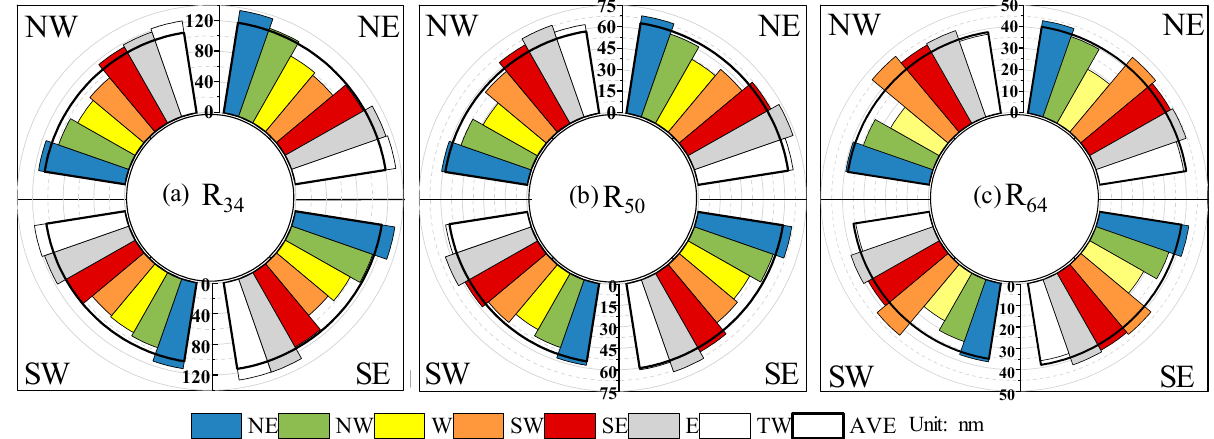
Figure 8. Average radii of ( a ) 34-kt, ( b ) 50-kt, and ( c ) 64-kt wind in four quadrants for TCs in each subregion (unit: nm). The thick black outline is the average radius for all samples in each quadrant. To quantify further the asymmetry of TCs in di ff erent subregions around Taiwan Is- land, the wind asymmetry ( α ) de fi ned by Song and Klo tz bach [8] is analyzed: 𝛼 = (cid:2869) (cid:3493)(𝑅 − 𝑅 ) (cid:2870) + (𝑅 − 𝑅 ) (cid:2870) , (1) (cid:2898)(cid:2889) (cid:2903)(cid:2907) (cid:2903)(cid:2889) (cid:2898)(cid:2907) (cid:2870) where R NE , R SW , R SE , and R NW are the radii in the northeast, southwest, southeast, and northwest quadrants, respectively. When the wind fi eld of the TC is symmetric, α will be zero. Additionally, a larger α indicates a more asymmetric TC wind structure.